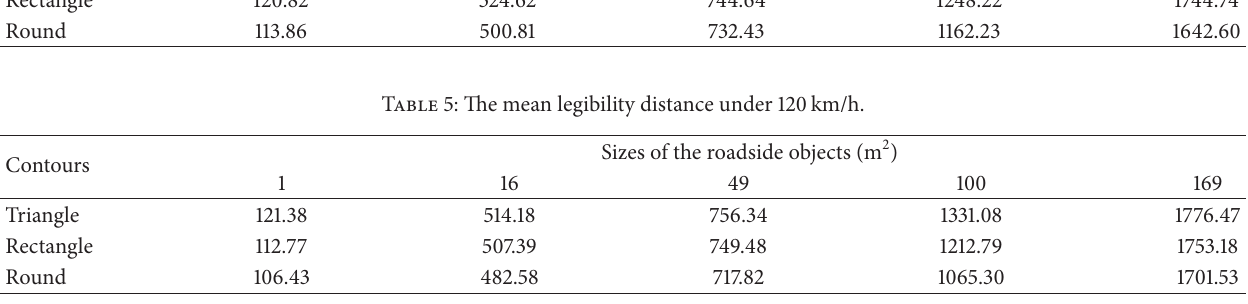
Table 6: Pearson correlation analysis of the variables.